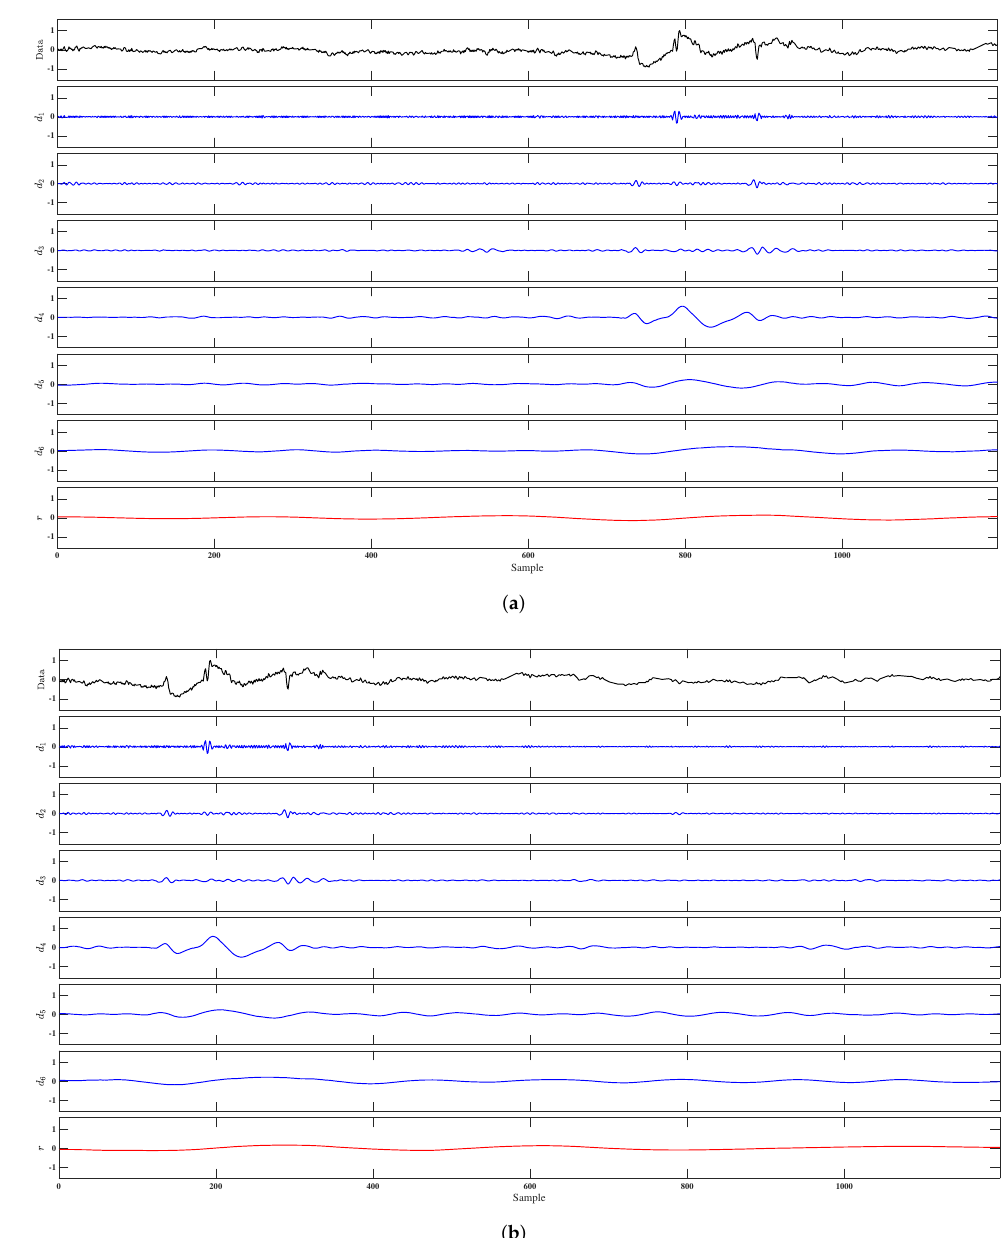
Figure 13. Oscillation decomposition using MEEMD algorithm for randomly selected pair of over- lapping sub-datasets for y signal. The first subplot shows original data (Data) and the consecutive plots show decomposed frequencies and the residuum in the last subplot. ( a ) Results for 32 of 50 subdatasets ( d 132 ), ( b ) Results for 32 of 49 subdatasets ( d 233